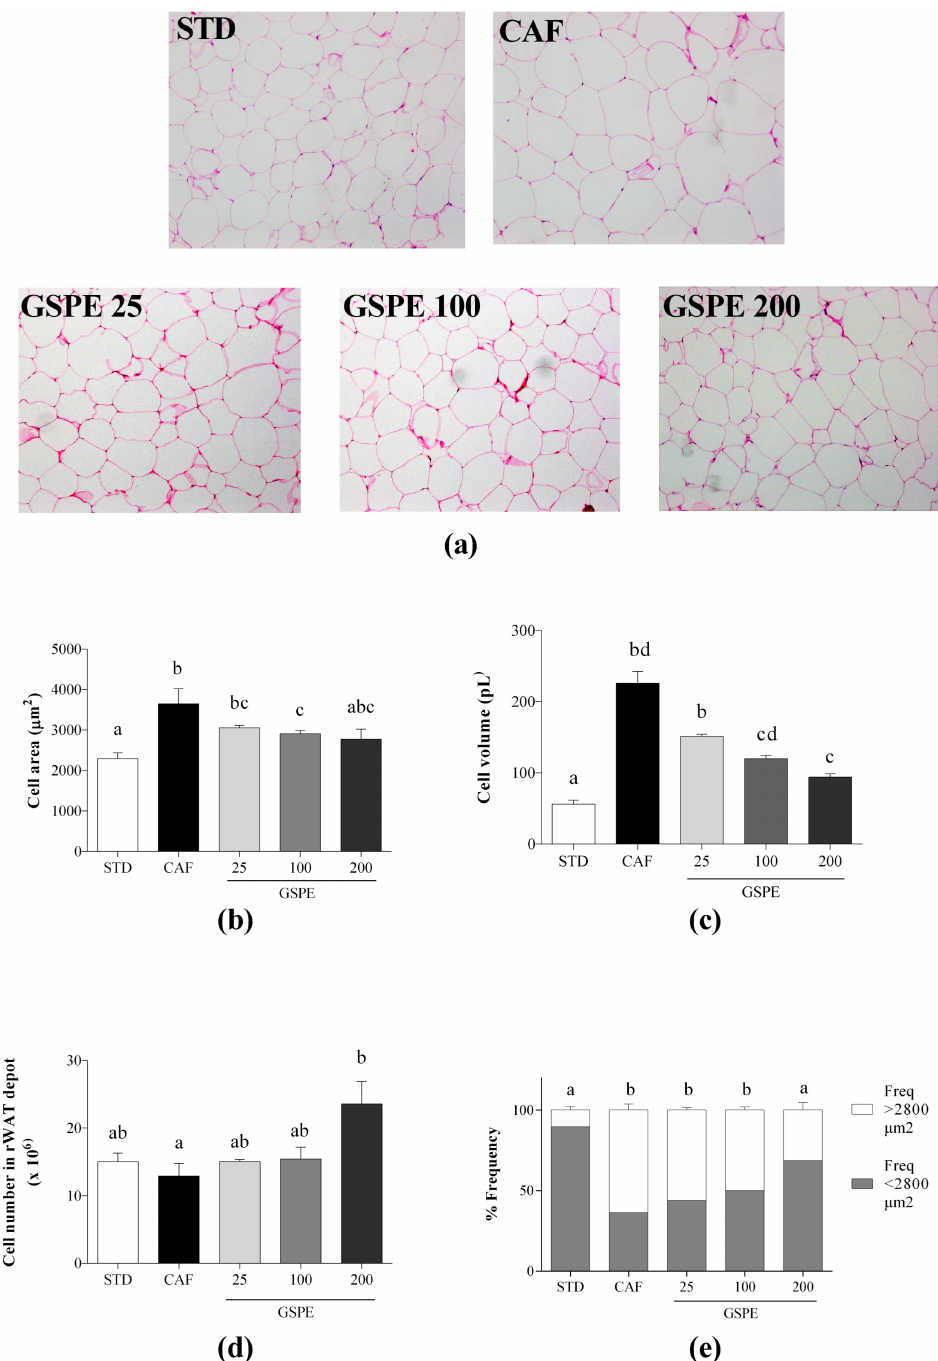
Figure 1. Effect of the long-term administration of a grape seed proanthocyanidin extract (GSPE) with an obesogenic diet on the size and number of visceral adipocytes. Rats were fed either a standard chow diet (STD group, n = 10), a cafeteria diet (CAF group, n = 10), or a cafeteria diet with daily administration of 25 mg GSPE/kg BW, 100 mg GSPE/kg BW or 200 mg GSPE/kg BW (GSPE 25, GSPE 100, and GSPE 200, n = 10 per group) for 12 weeks. ( a ) Representative light microscopy images of retroperitoneal white adipose tissue (rWAT) stained with hematoxylin and eosin from each group; ( b ) Adipocyte area measured from the representative light microscopy images from each group; ( c ) Adipocyte volume calculated from the adipocyte area; ( d ) Total adipocyte number extrapolated from the size of adipocytes and the weight of rWAT; ( e ) Frequency of adipocyte size calculated from the adipocyte area. The values are the means ± SEM of five fields per animal from three animals of each group. Different letters indicate significant differences between groups using one-way ANOVA. Significance was considered when p ≤